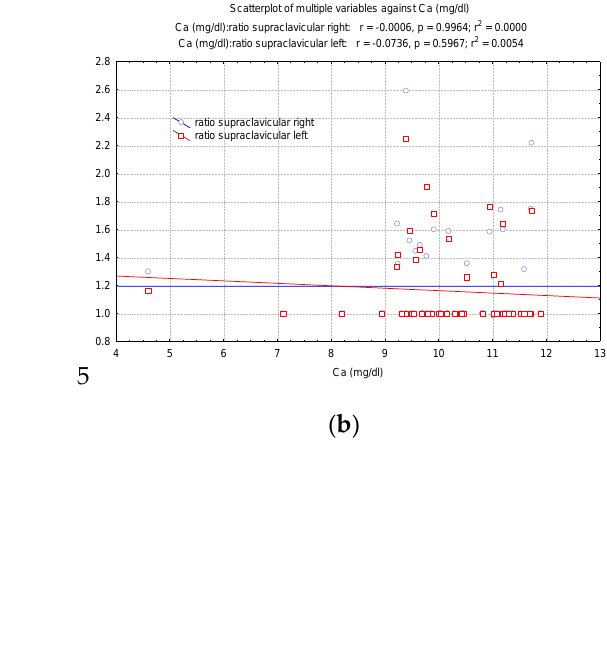
Figure 4. Pearson correlations between some endocrine hormones ( a , b ) PTH, ( c,d ) TSH, ( e,f ) FT4 and the values of (total counts/pixels) BAT /(total counts/pixels) non-BAT ratio. As vitamin D increases, the right and left cervical BAT ratios decrease (r = −0 .304, p = 0.031 on the right; r = −0 .410, p = 0.012 on the left). Furthermore, the increase in magnesium leads to a decrease in the right and left supraclavicular BAT ratios. It was noted that the increase in creatinine and urea was followed by a significant decrease in the right and left supraclavicular BAT ratios (Figure 5).